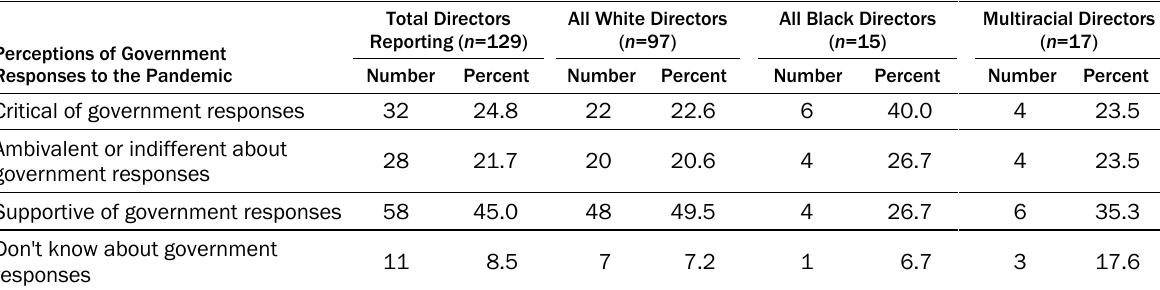
Table 9. Race/Ethnicity of Emergency Food Assistance Directors and Perceptions of Government Responses to the COVID-19 Pandemic